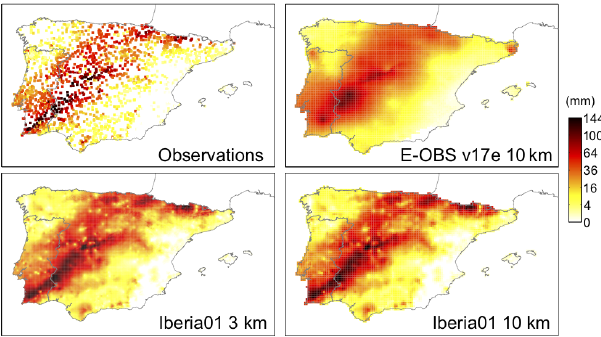
conveys relevant information on the station network used to